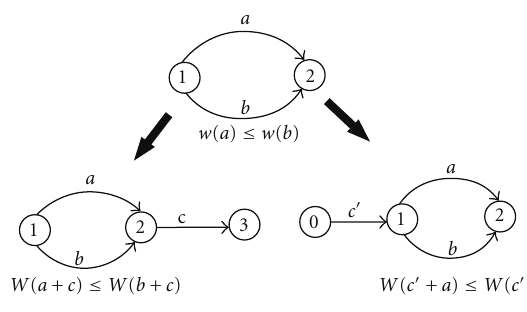
Figure 2: Example of